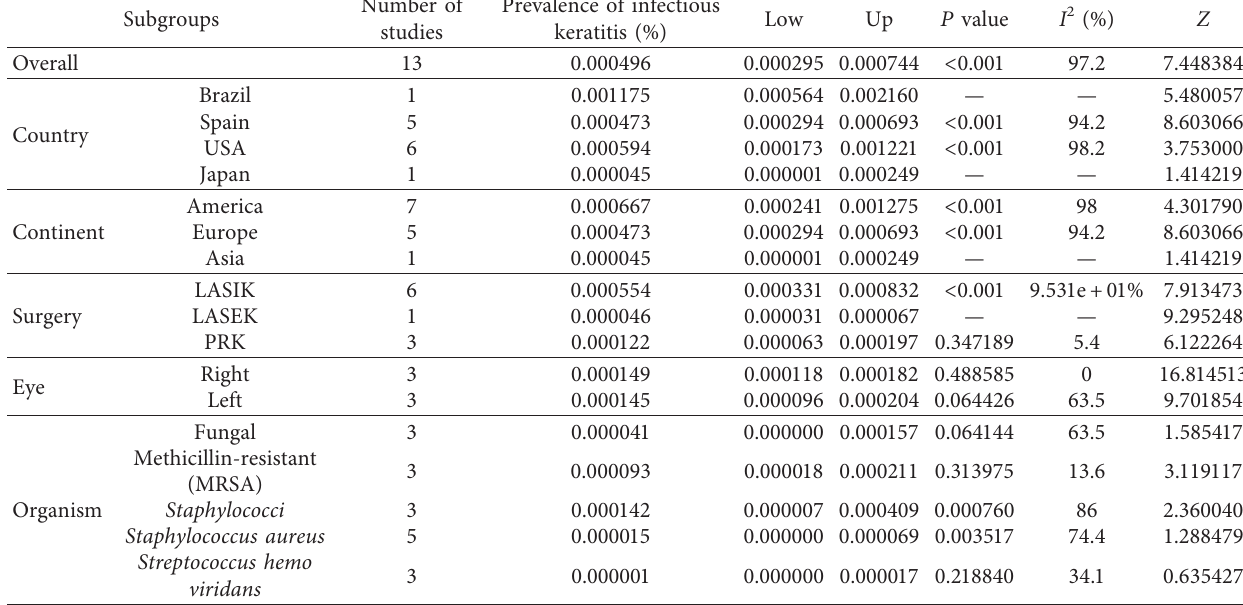
Table 2: Results of the meta-analysis of